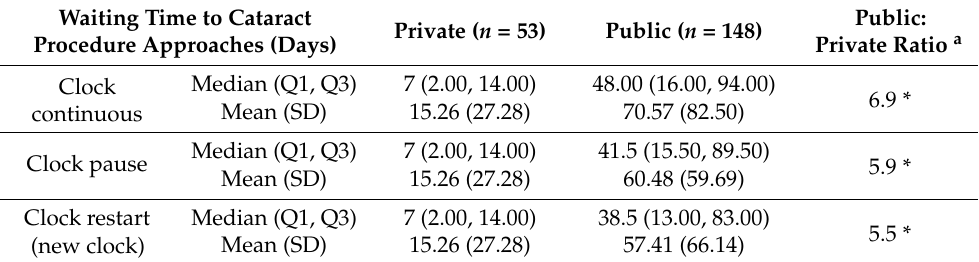
Table 2. Median and mean waiting time to cataract procedure (in days) for public and private groups.